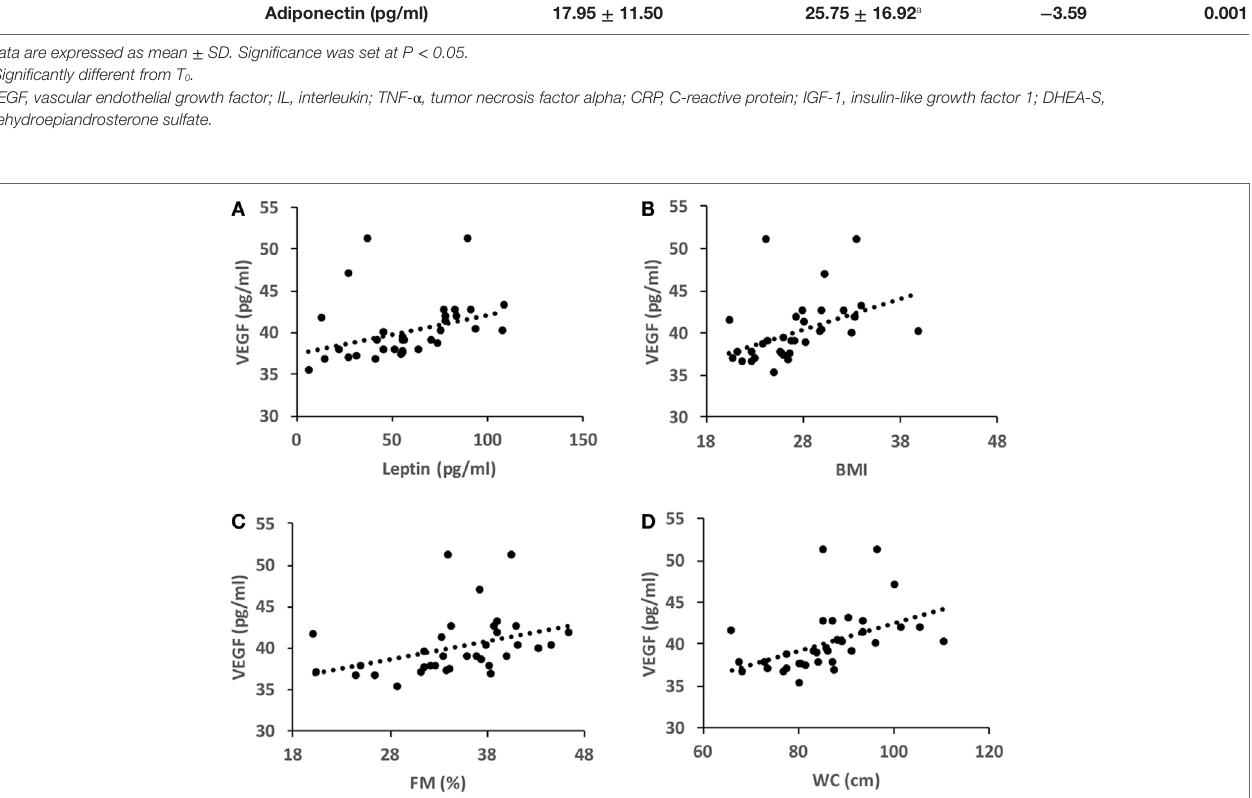
FigUre 1 | Pearson’s correlation coefficients in basal conditions ( T 0 ). (a) r = 0.343, P = 0.047; (b) r = 0.438, P = 0.01; (c) r = 0.468, P = 0.005; (D) r = 0.361, P = 0.036. BMI, body mass index; WC, waist circumference; FM%, fat mass percent.